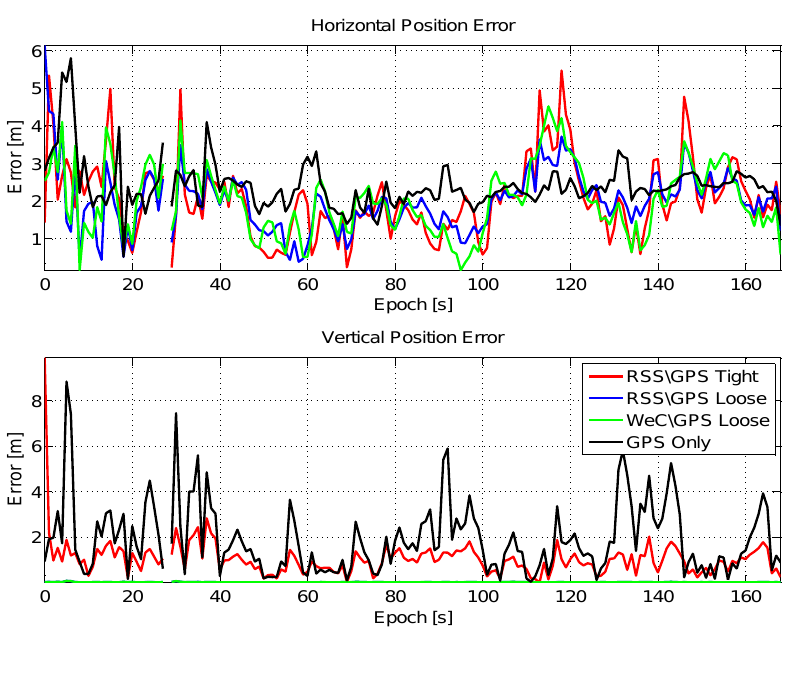
Figure 20. Horizontal and vertical errors as a function of time, hybrid